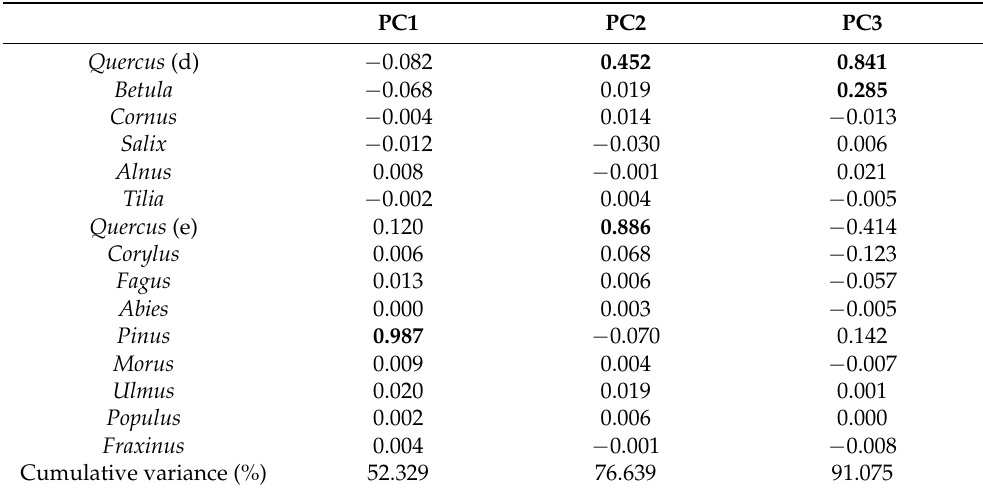
Figure 13. Successional variations in the forest assemblages defined in Figure 8 and rate of change. SED, standardized Euclidean distance. Rate of change values have been calculated using all taxa of Figure 4. Table 3. PCA variable loadings and variance explained by the three significant components (PC1 to PC3), according to Kaiser’s rule [62]. The highest loadings are in